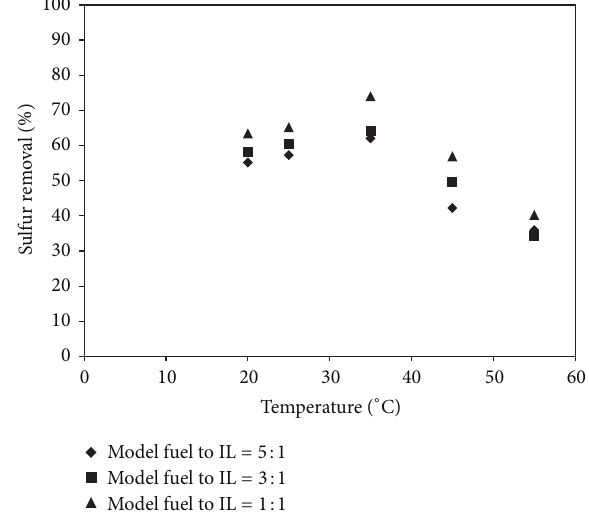
Figure 9: Removal of sulfur from model fuel (DBT in octane) using [BMIM]Cl at different extraction temperatures ( ∘ C) (temperature = 20 − 55 ∘ C, extraction time = 30 min., initial sulfur concentration = 500